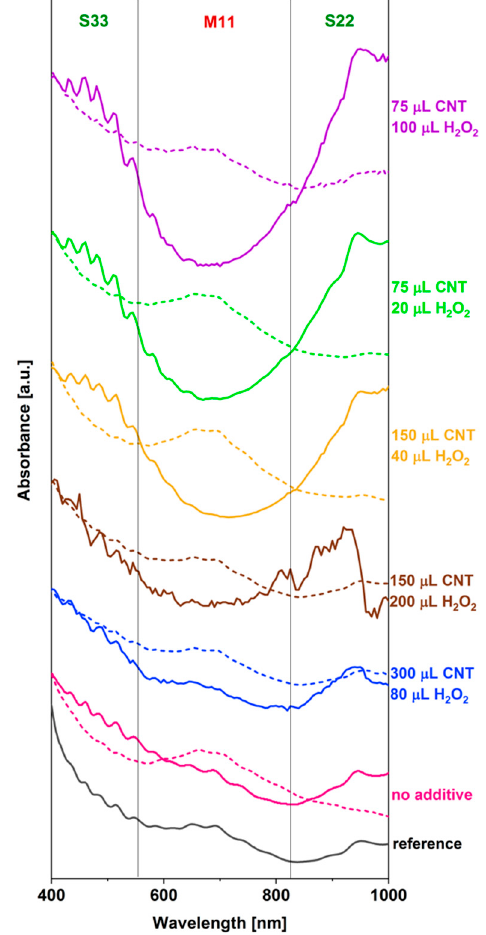
Figure 4. The influence of the volume of the CNT dispersion and hydration modulating agent (H 2 O 2 ) in the ATPE system on the course of the separation. Dextran-rich bottom phase (dashed line), PEG-rich top phase (solid line).